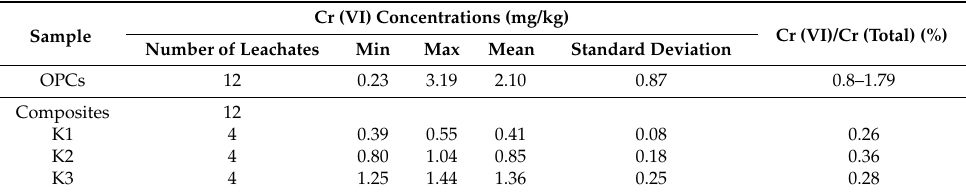
Table 3. The concentrations of water-soluble